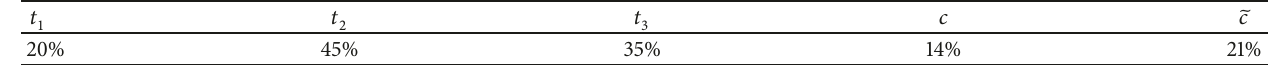
Table 6: Parameters for calculating 𝐸 𝑐𝑜𝑛 and 𝐸 𝑏𝑟𝑎 .